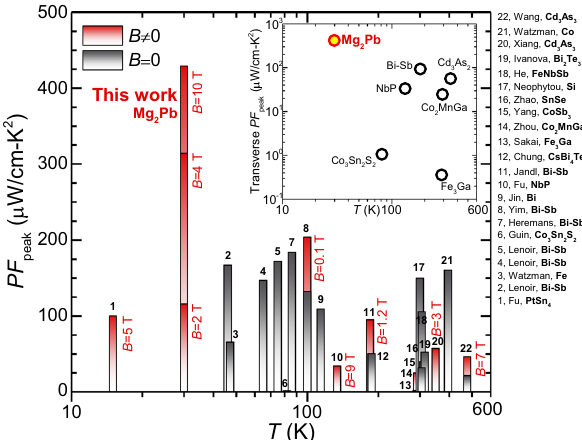
Fig. 7 Peak power factors. Peak power factor ( PF peak ) of Mg 2 Pb, as compared to literature results of either longitudinal or transverse thermoelectrics 18 – 20,29,42,45 – 53 with (red bars) or without (black bars) magnetic fi elds. The inset compares the transverse PF peak for typical semiconductors and